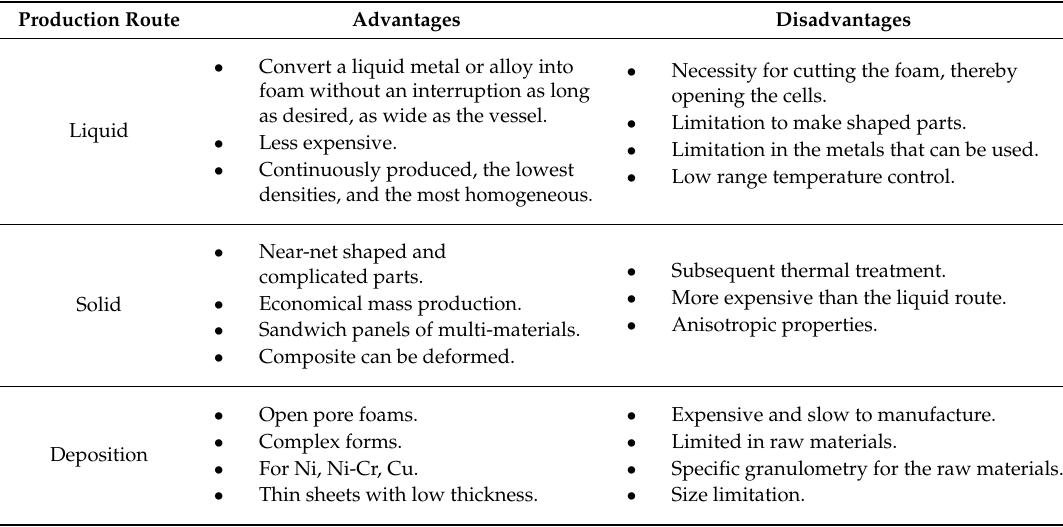
Table 1. Pros and cons of different foams production routes.